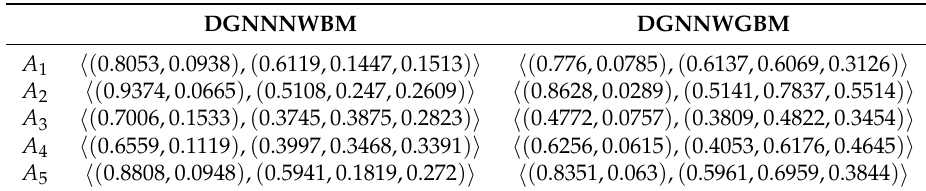
Table 11. The DGNNNWBM operator and DGNNWGBM operator R = ( 10,10,10,1 ) . DGNNNWBM DGNNWGBM